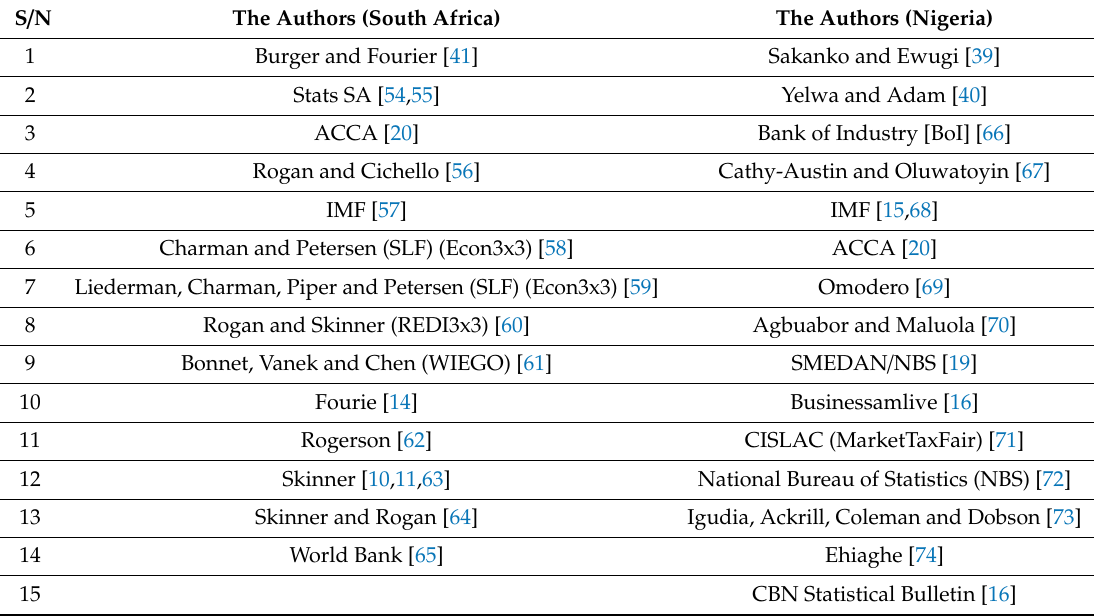
Table 8. Systematic Literature Review of